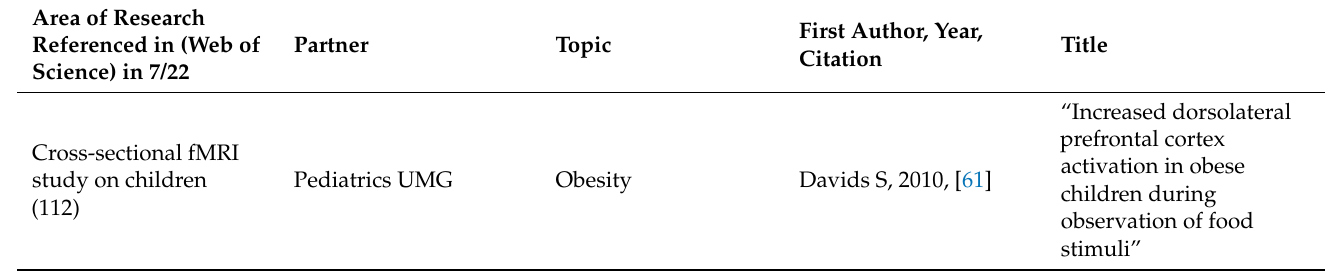
Table 1. Papers from the fMRI unit that were referenced more than 50